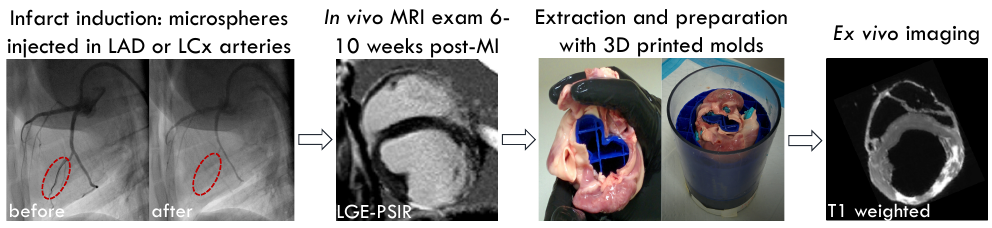
Figure 1. Experimental procedure: infarct induction and MR